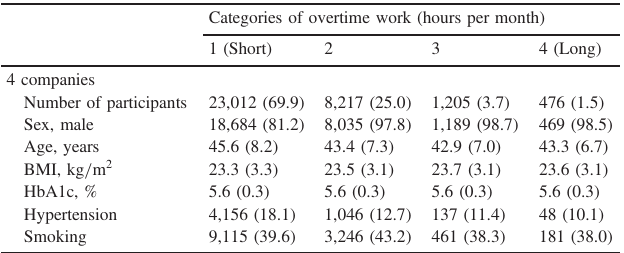
Table 1. Baseline characteristics of participants according